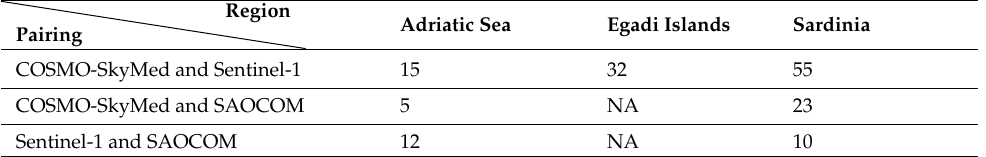
Table 2. Number of couplings for each scenario of interest of the MM/MF dataset. Region Adriatic Sea Egadi Islands Sardinia Pairing COSMO-SkyMed and